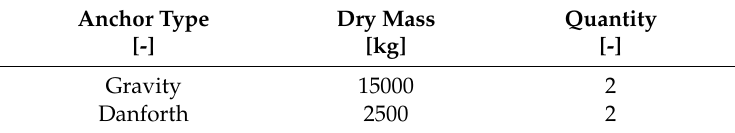
Table 3. Anchor properties.